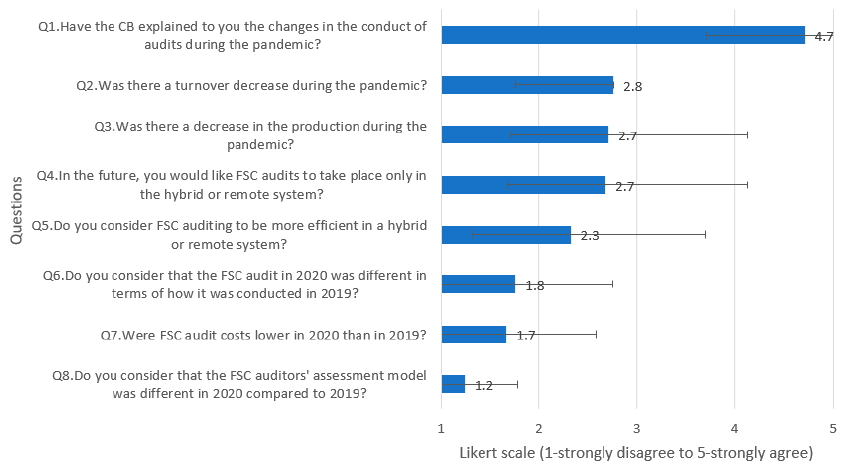
Figure 2. Perceptions of FCS CoC certified companies regarding the audits performed during COVID-19 pandemic (error bars represent the extreme answers).